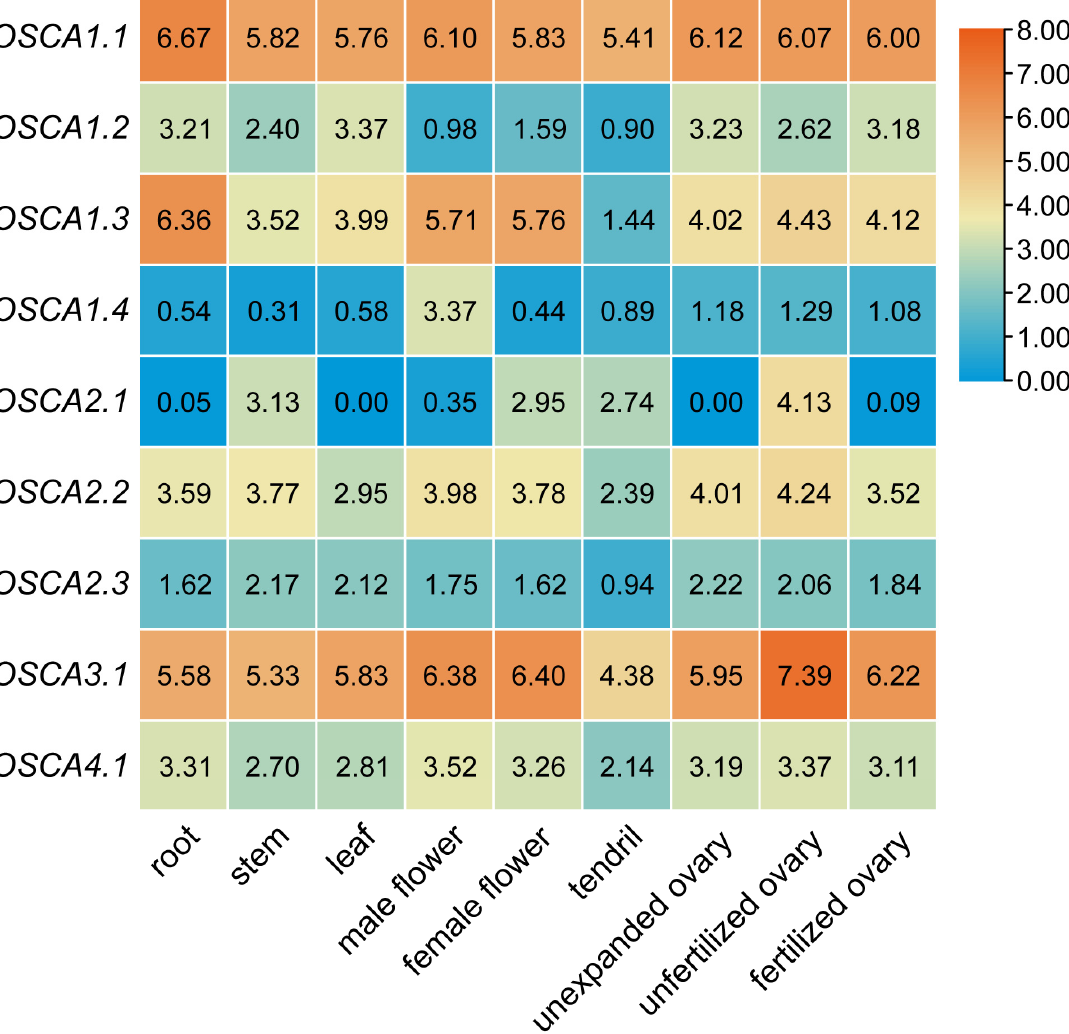
Figure 5. Expression profiles of CsOSCA genes in different cucumber